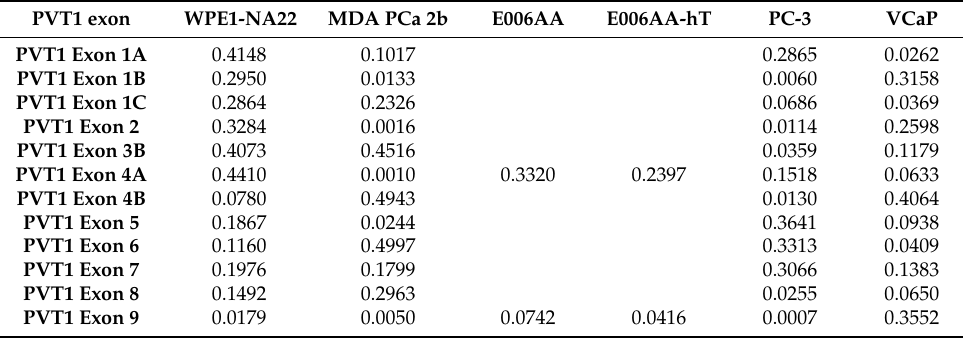
Table 3. Summary of p values comparing each prostate cell line to the normal prostate cell line RWPE1 for all PVT1 exons.